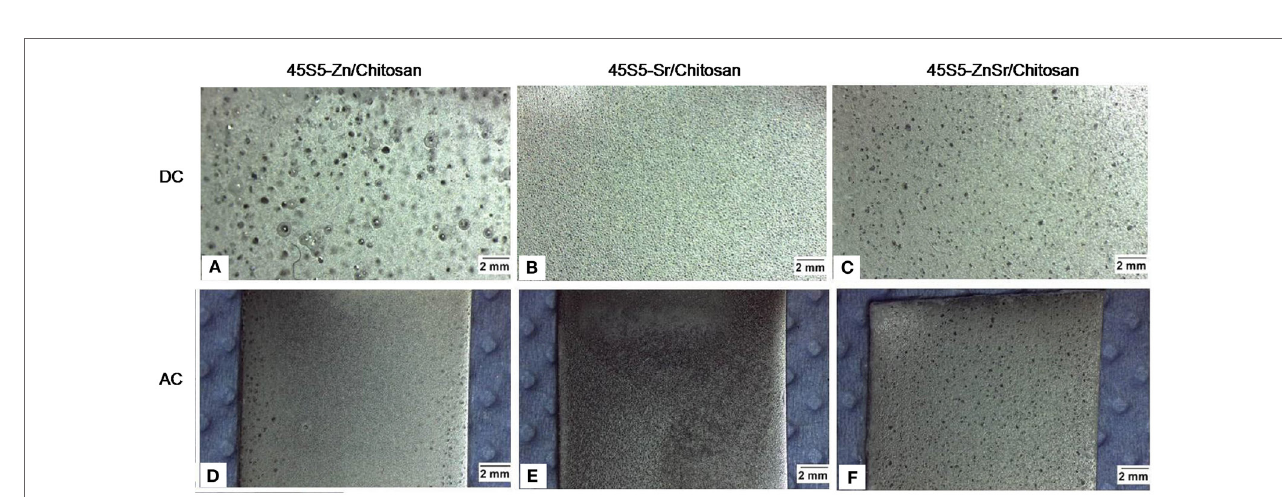
FigUre 5 | images of the electrophoretic coatings using both Dc (a–c) and ac-ePD (D–F) for the different chitosan/Bg systems investigated